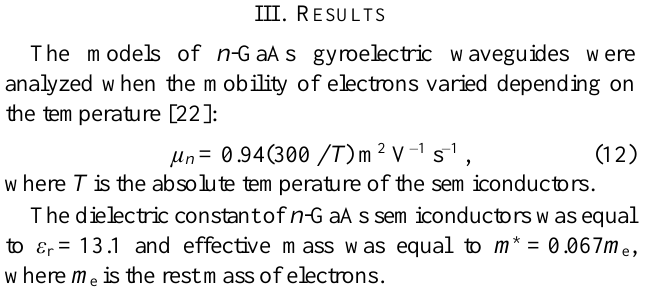
Fig. 4. Wave phase characteristics of models of gyroelectric n -GaAs semiconductor-dielectric waveguides, when d / r s = 0.3; B 0 = 1 T; N = 10 17 m –3 .